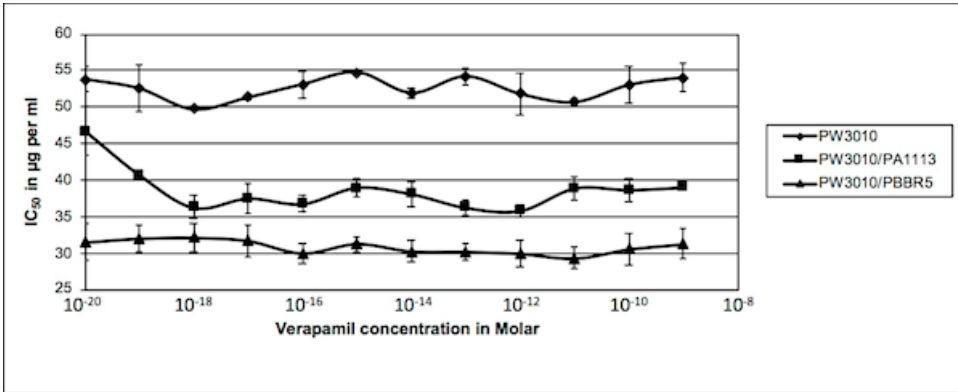
Figure 5. Effects of verapamil on sensitivity to carbenicillin of mutant PW3010 and PW3010 transformed either with pBBR5-PA1113 or the empty vector. PAO1 PW3010 mutant ( ♦ ), PW3010 transformed with plasmid pBBR5 containing the wild PA1113 gene ( ■ ), and PW3010 transformed with the empty vector pBBR5 ( ▲ ) were inoculated in 96-well plates with increasing concentrations of verapamil and carbenicillin. Growths and IC 50 values were measured as described in the legend of Figure 1. The IC 50 values were plotted against concentration in verapamil. Results presented were the mean values of at least four independent experiments.